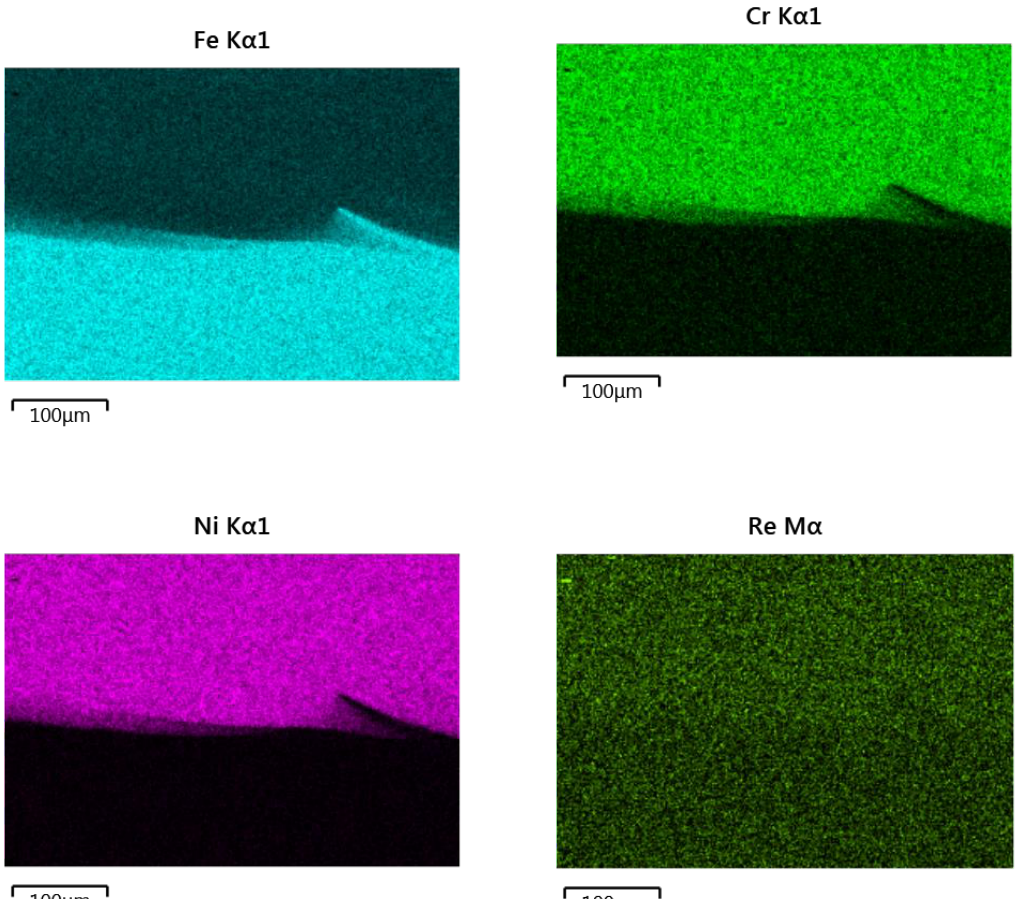
Figure 12. Surface element distributions at the interface in the Ni-Cr20+Re clad sample (shown in Figure 11b) produced at 2400 W laser power.